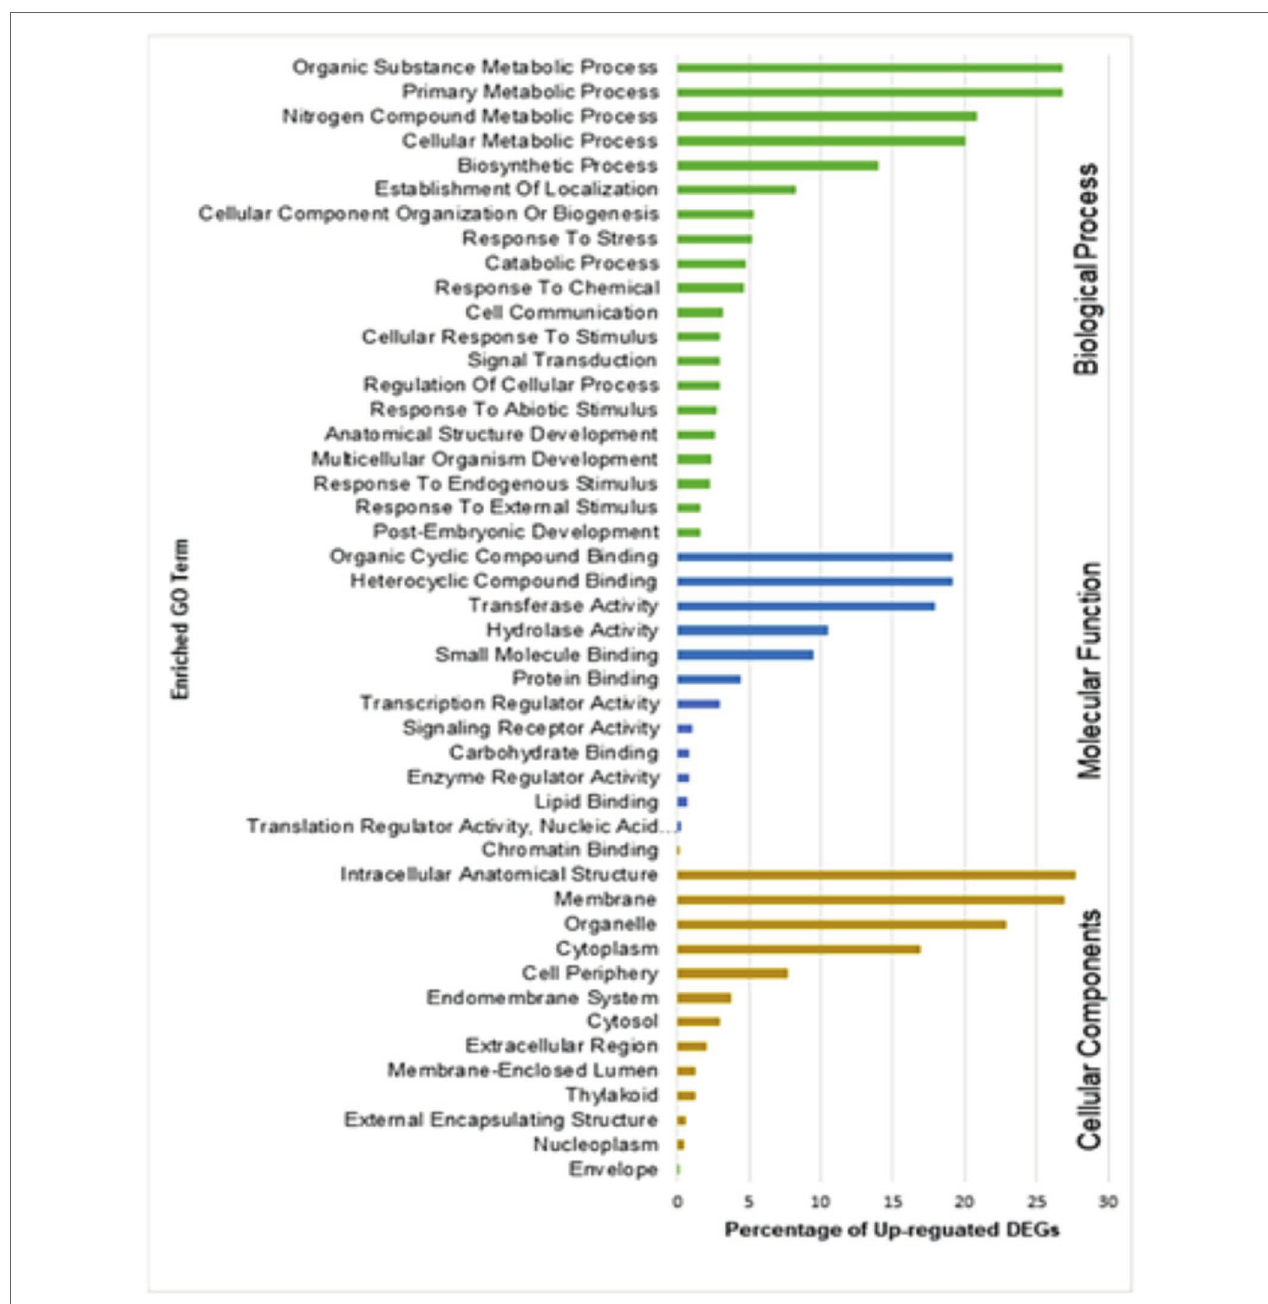
FIGURE 6 | Gene ontology (GO) enrichment analysis of DEGs upregulated in resistant genotype QL3 vs. Theis.